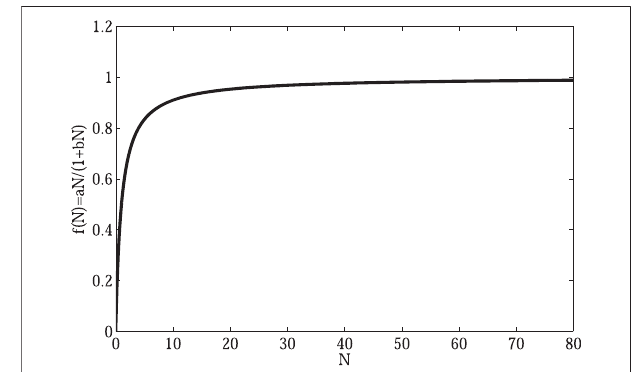
FIGURE 1 | Saturated water absorption on vegetation. When the water concentrationissmall,thewaterabsorptionofvegetationwillincreasewiththe increase of water concentration. However, as the water concentration continues to increase, the water absorption of vegetation tends to be